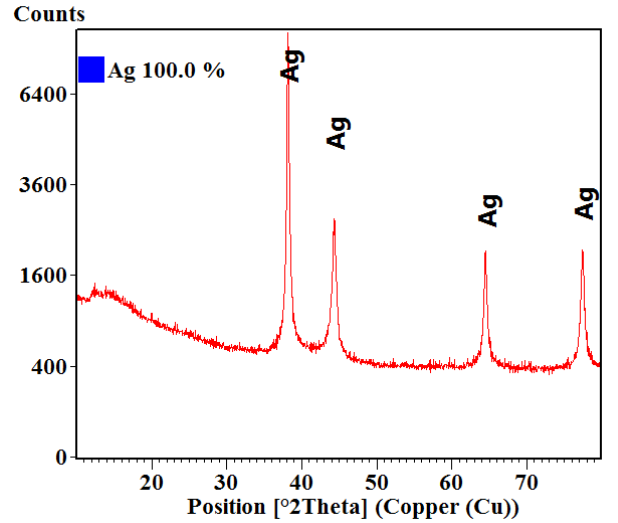
Figure 1. X-ray di ff ractogram for silver nanoparticles Figure 1. X-ray diffractogram for silver nanoparticles powder.